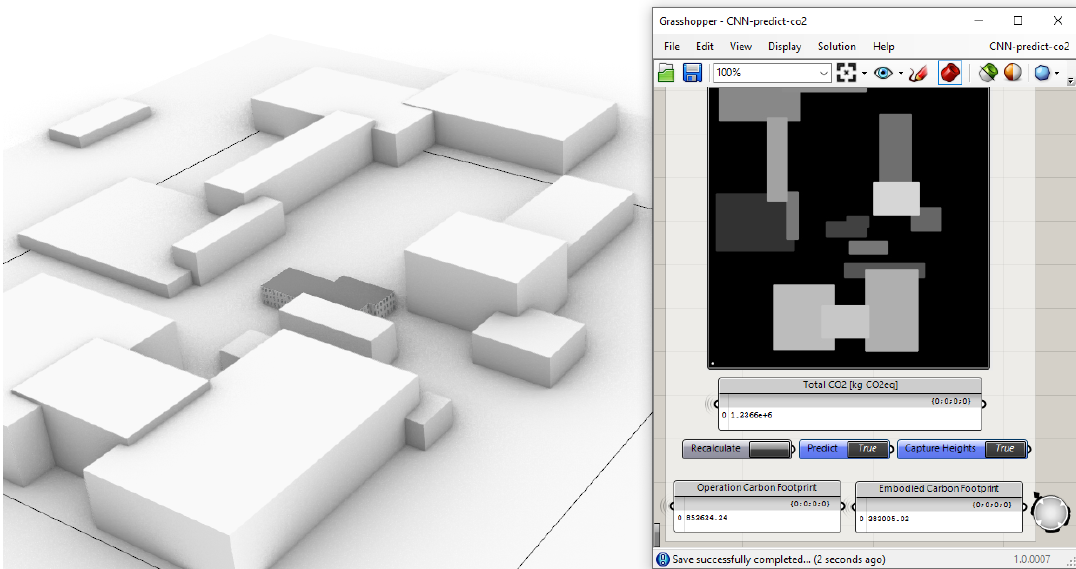
Figure 17. The updated script from Study 03 is able to predict the building’s Embodied and Operational Carbon Footprint based on the simplified model consisting of the building itself and simplified surroundings. The scripts take around 10–15 s to execute.